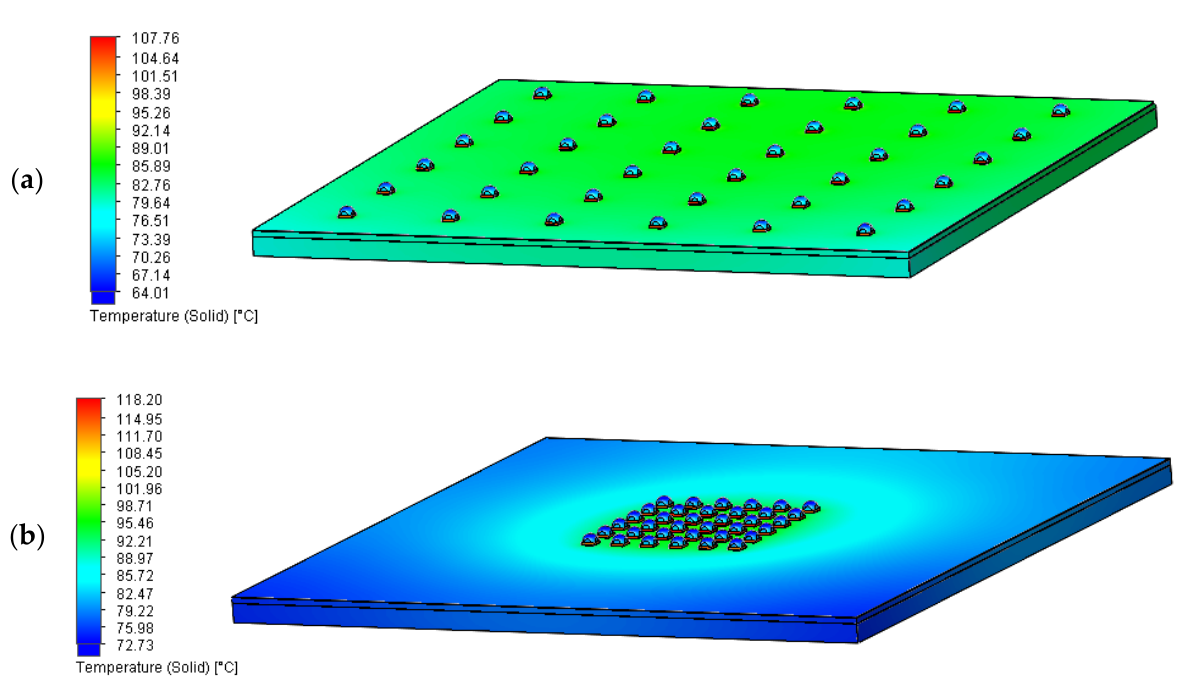
Figure 13. Temperature distribution of the LED panel at I F = 1050 mA: ( a ) d = 25 mm, ( b ) d = 5 mm. Temperature distribution of the LED panel along the axis with the maximum junction temperature T j of the installed LED sources for three values of forward current I F is shown in Figure 14.